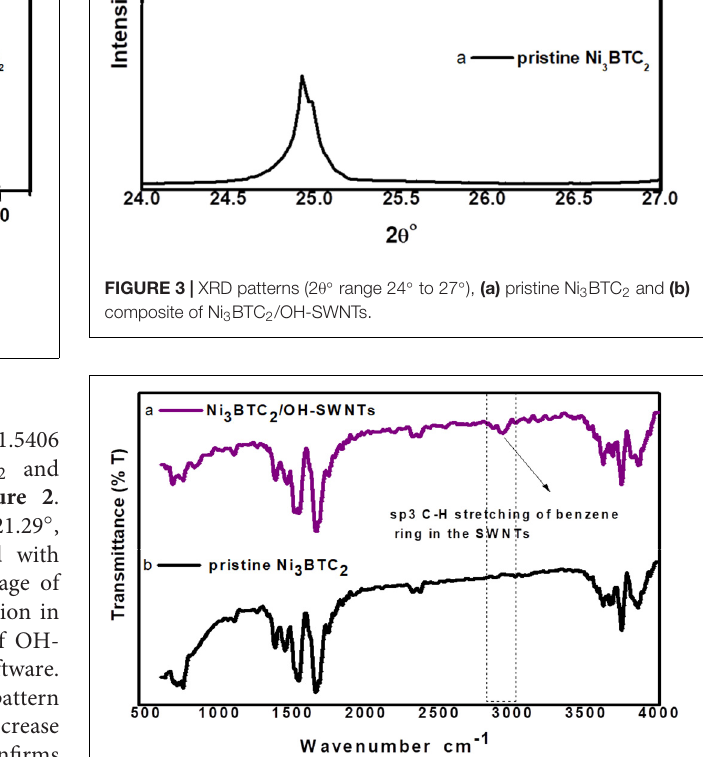
FIGURE 4 | FTIR spectras, (a) pristine Ni 3 BTC 2 and (b) composite Ni 3 BTC 2 /OH-SWNTs